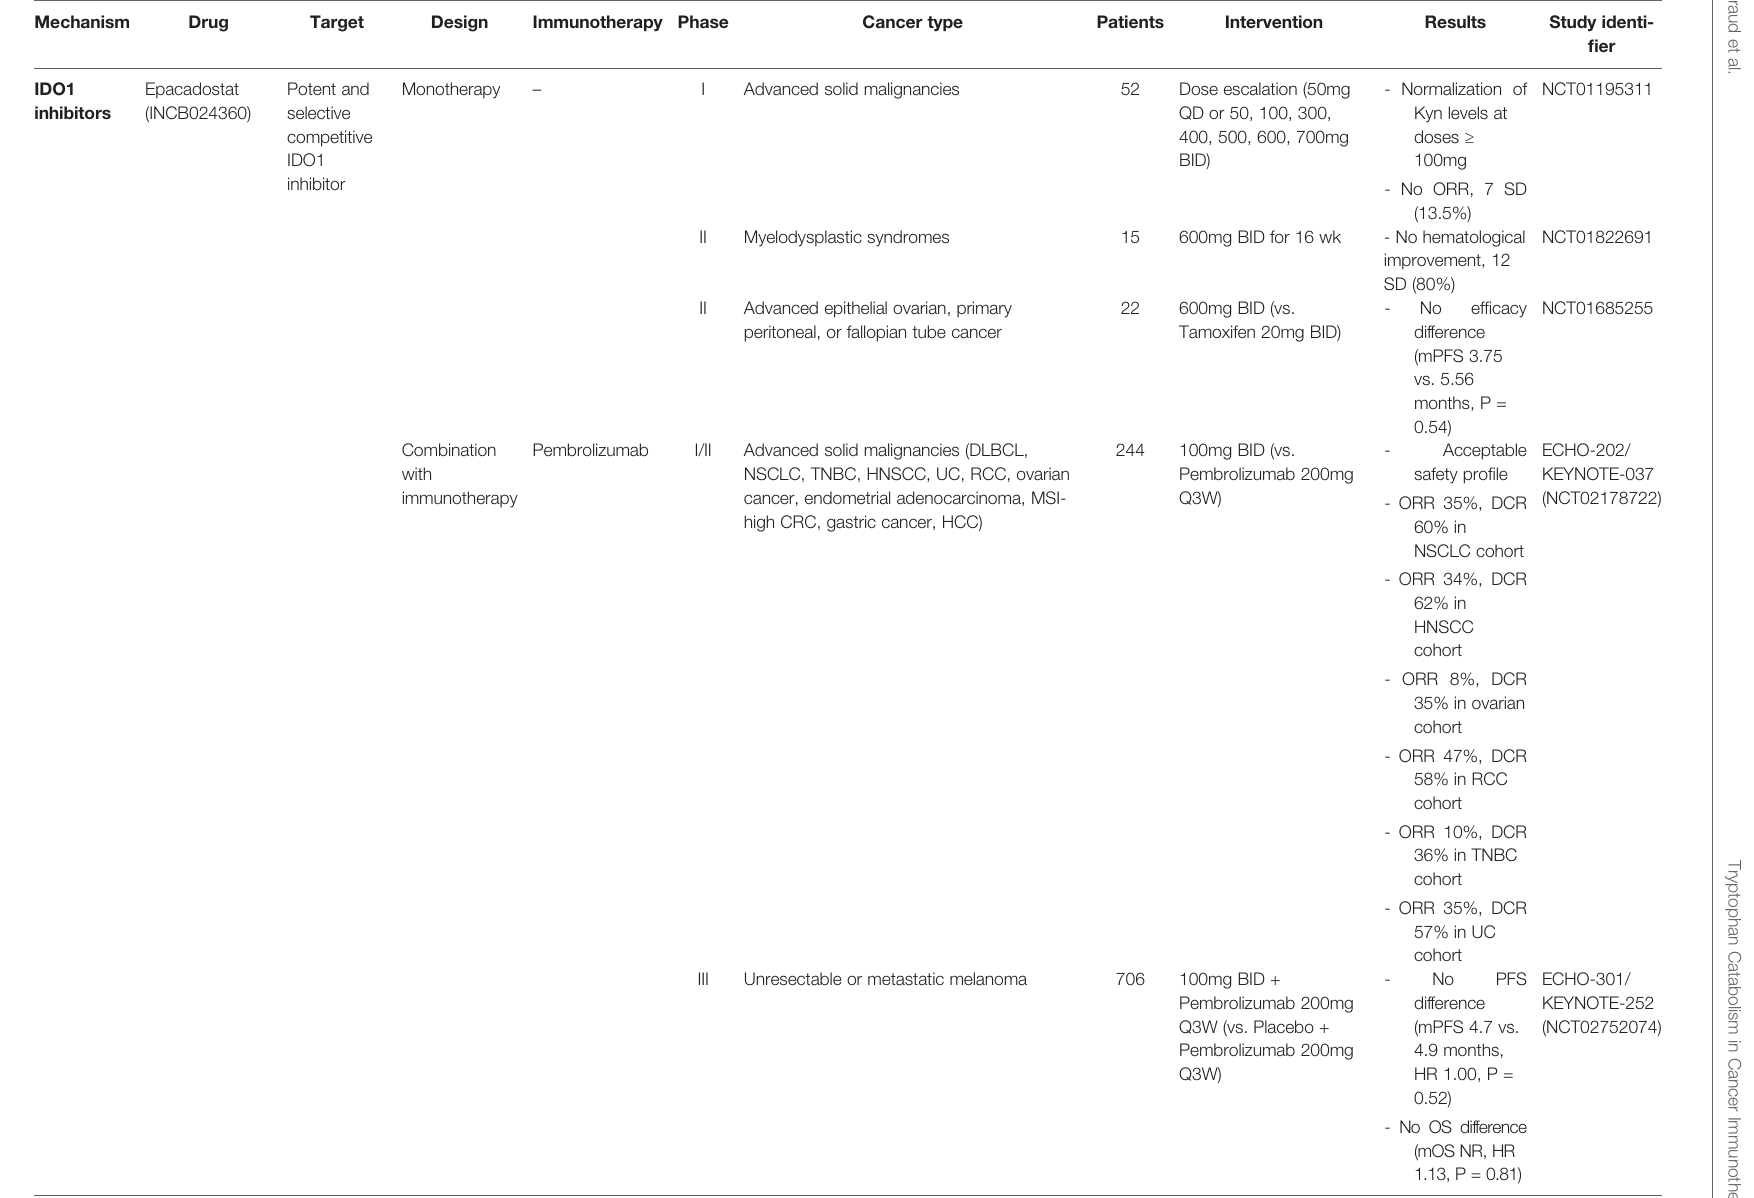
TABLE 2 | Clinical trials of IDO1